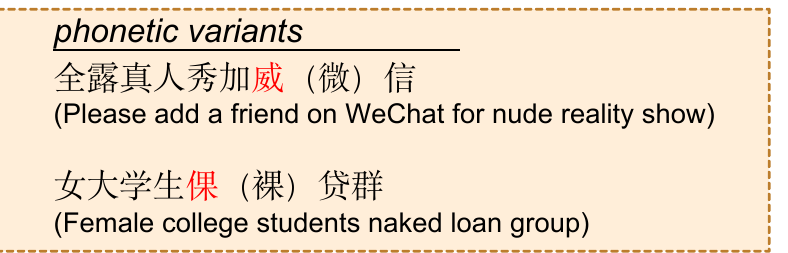
Figure 1. Camouflaged spam texts. The original characters are in brackets, whilst the variants are in